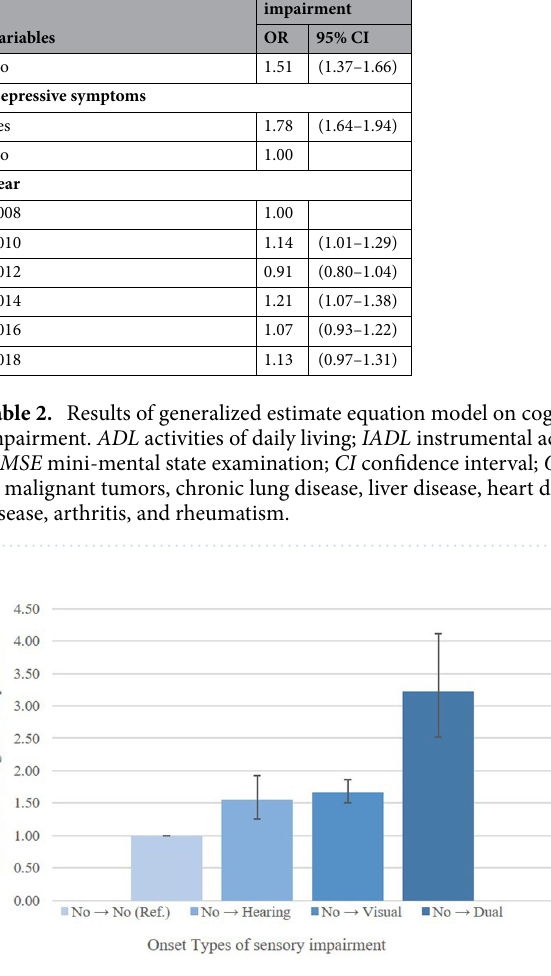
Figure 1. Results of generalized estimating equation model on cognitive function according to sensory impairment by types. Analysis was adjusted for all demographic, socioeconomic, and health-related factors considered in the study. Error bars represent 95% confidence